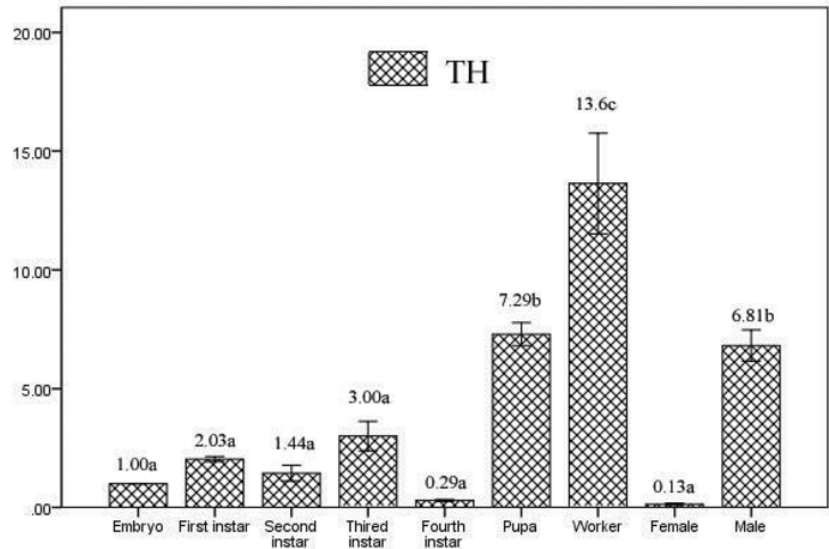
Fig.7. relative expression profiles (± standard error of the mean; n=3) for PvtH in different developmental stages of P.vicina based on real-time Pcr. All expression levels are shown relative to the expression level in embryos. Means followed by the same letter are not significantly different (p<0.05).